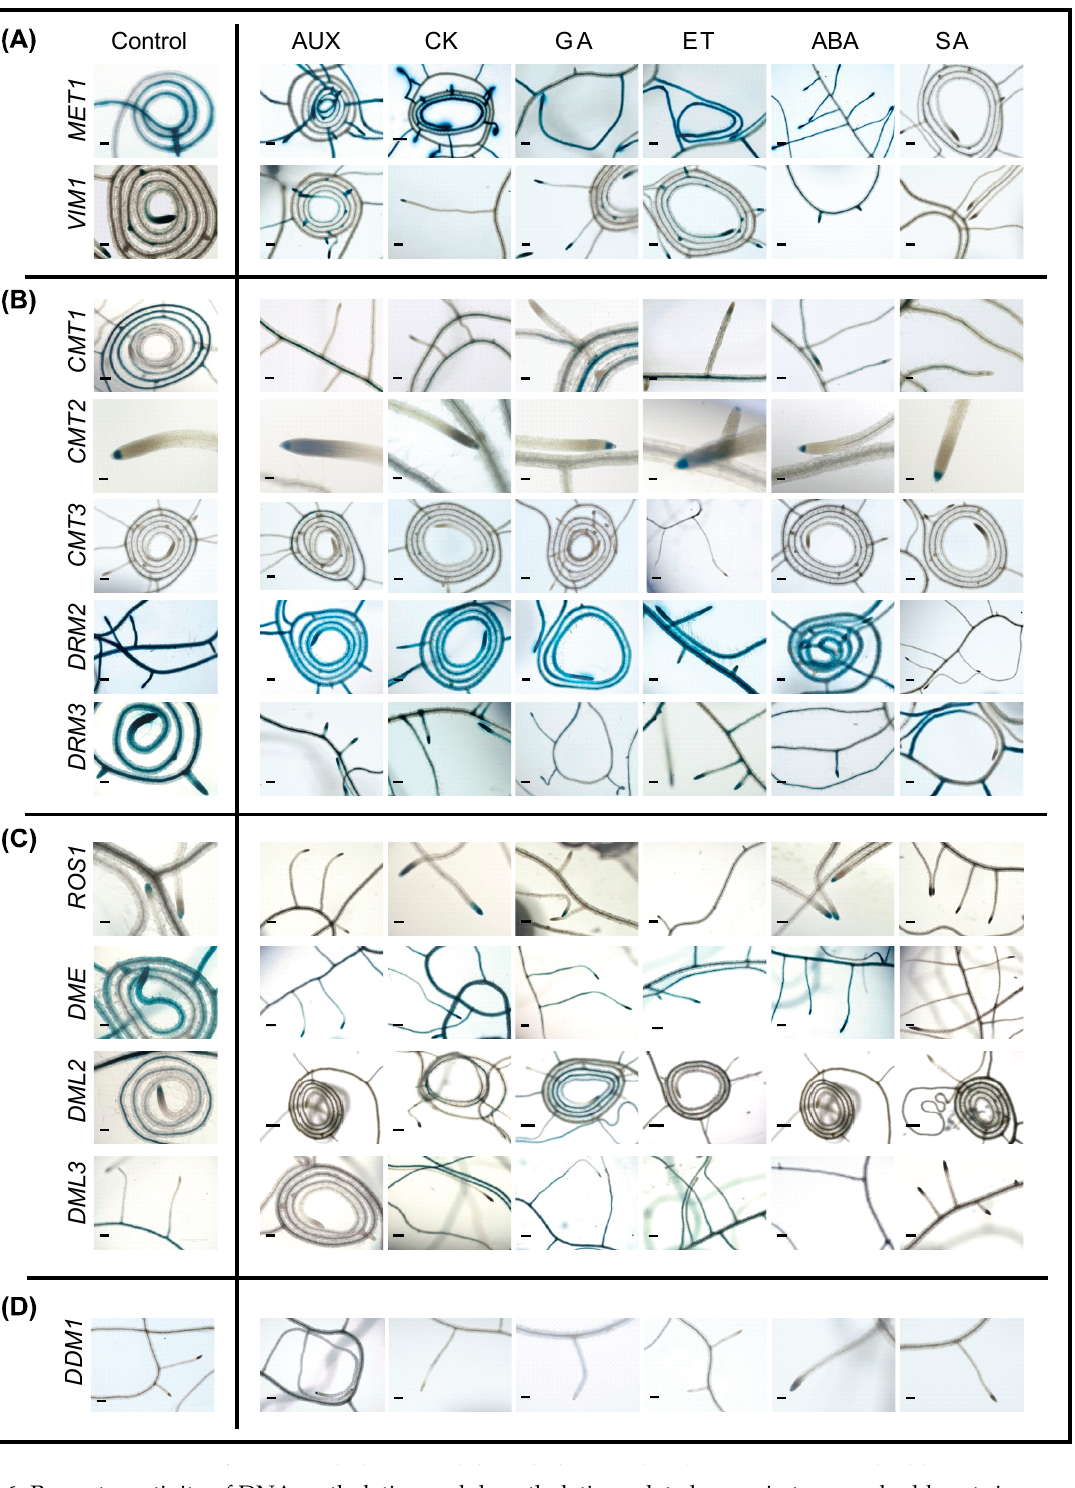
Figure 6. Promoter activity of DNA methylation and demethylation-related genes in two-week-old roots in response to phytohormone treatments. A–C: Histochemical localization of GUS activity directed by promoters of the CG methylation- related genes MET1 and VIM1 ( A ), the non-CG and RdDM-related methyltransferases CMT1 , CMT2 , CMT3 , DRM2 , and DRM3 ( B ), the demethylases ROS1 , DME , DML2 , and DML3 ( C ), and DDM1 ( D ) in two-week-old roots in response to exogenous application of auxin (AUX), cytokinin (CK), gibberellic acid (GA), ethylene (ET), abscisic acid (ABA), and salicylic acid (SA). Scale bar = 5 mm.